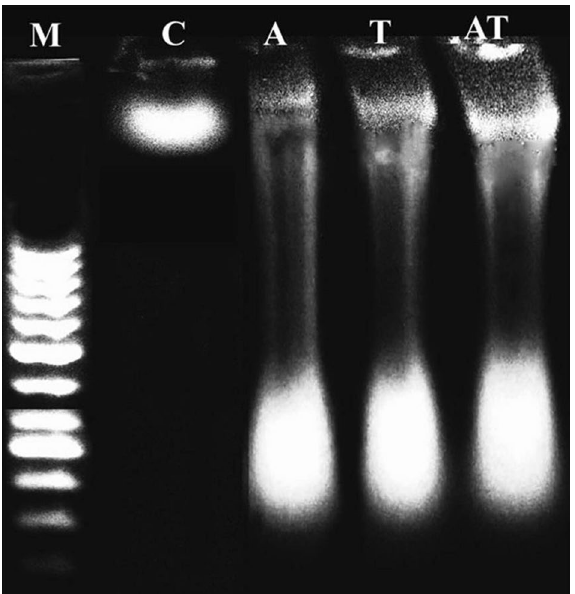
Figure 4. Electrophoresis pattern of the extracted genomic DNA from the negative control group (C) and groups administrated acrylamide (A), TiO 2 NPs (T), and acrylamide with TiO 2 NPs (AT) on an ethidium bromide stained agarose gel. M: Marker.